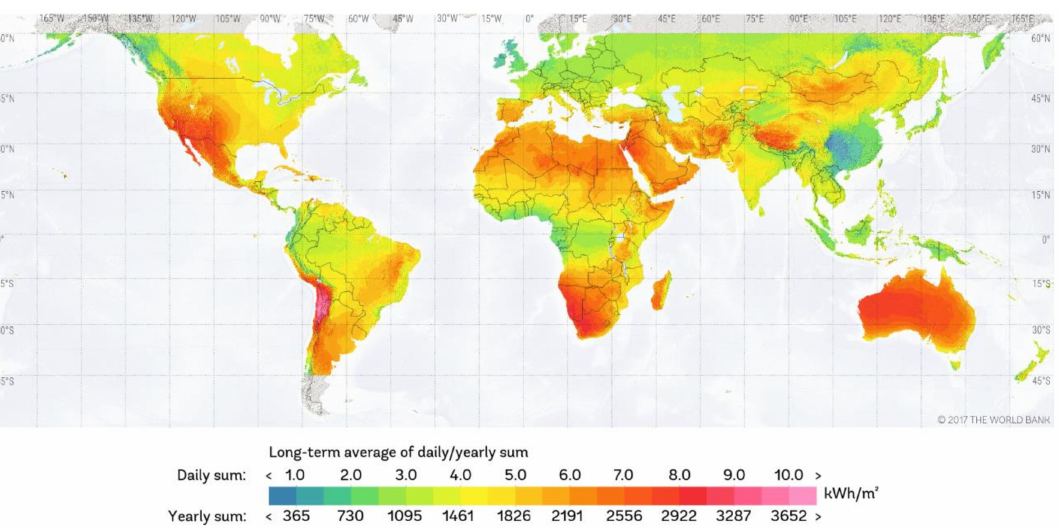
Figure 2. Distribution map of direct normal irradiation [36].